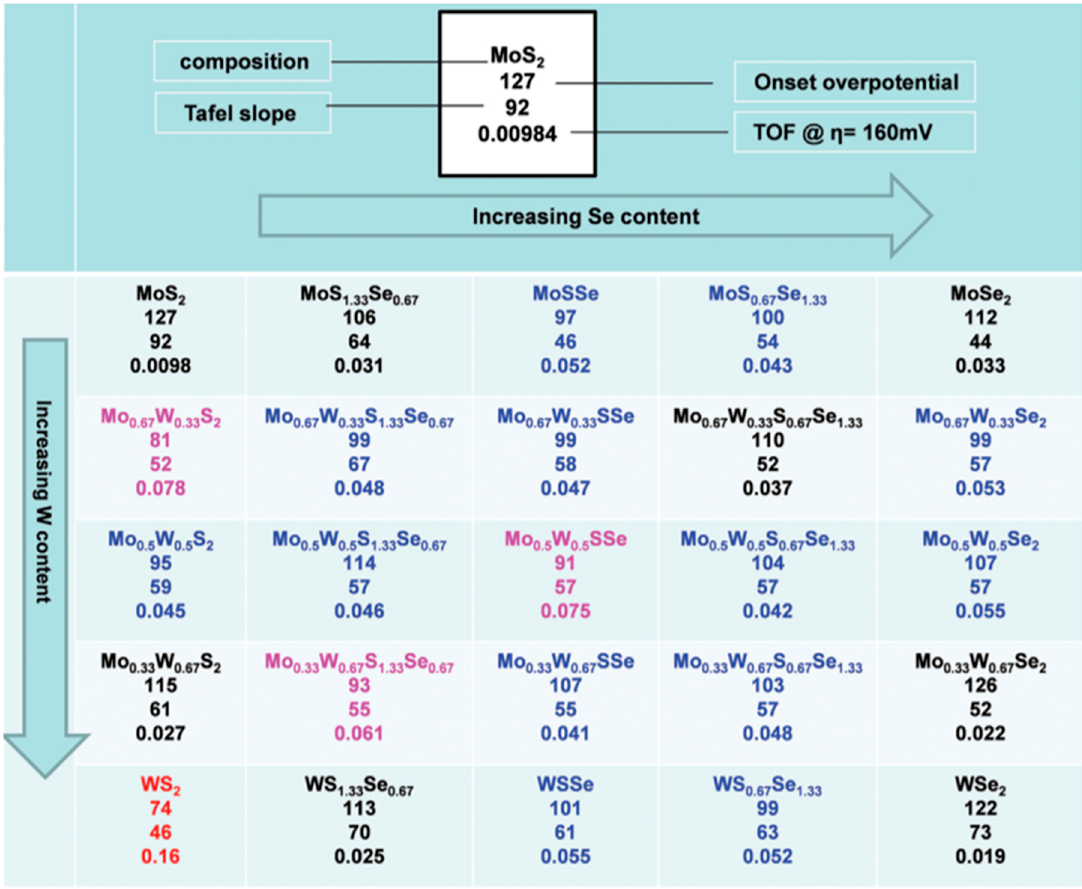
Figure 10. Summarizing the onset overpotential, Tafel slope and TOF @ η = 160 mV of different compositions. The red color labels compositions with TOF > 0.1 s − 1 ; the magenta color labels compositions with 0.06 < TOF < 0.1 s − 1 ; the blue color labels compositions with 0.04 < TOF < 0.06 s − 1 . Adapted with permission from Reference [139], copyright (2016), Wiley-VCH.